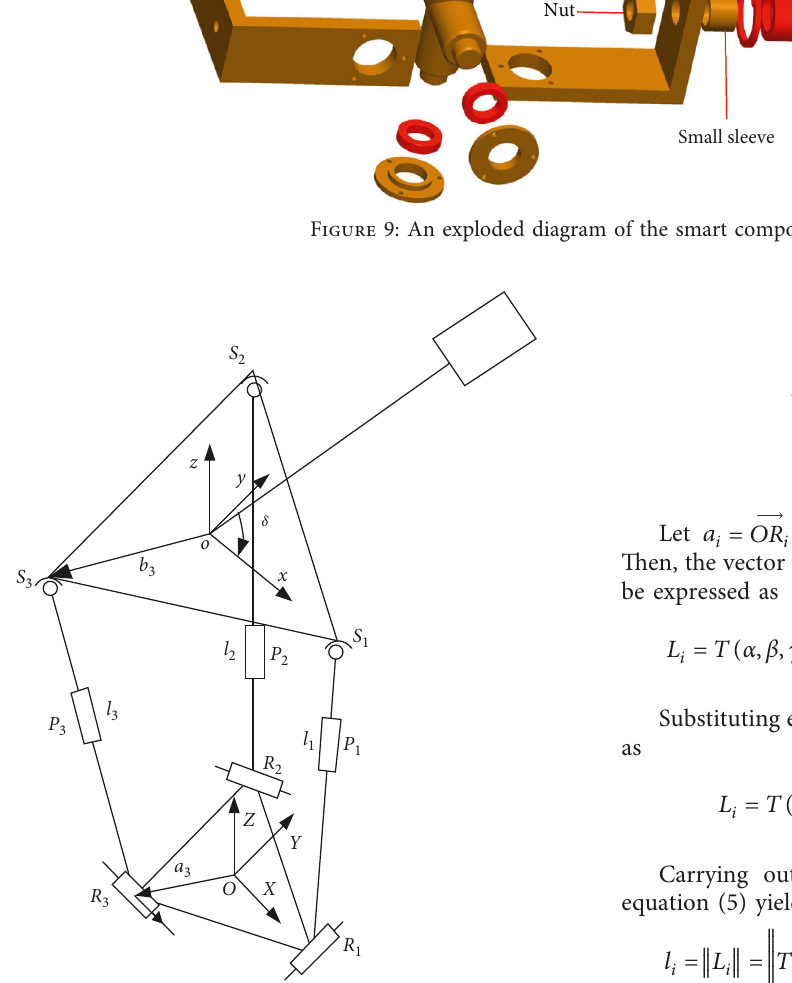
Figure 10: Geometry of the TER pointing